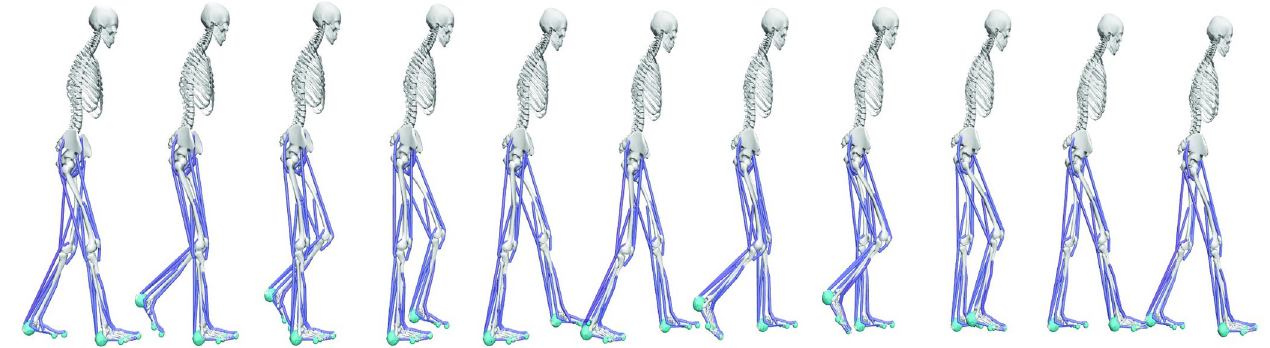
Fig 3. Time lapse images. Optimal result of model [86] walking at 1.00 m/s in the base condition. Blue line segments show muscle paths for the 18 muscles in the model, and the light blue spheres at the feet show the arrangement of the foot-contact elements. The OpenSim image depicted is based on models available at simtk.org and the specific model and data shown here can be downloaded from https://simtk.org/projects/post-stroke-sym.